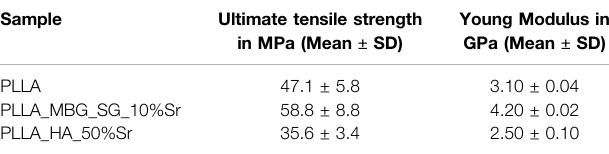
TABLE 1 | Values of ultimate tensile strength and Young Modulus for PLLA and composite